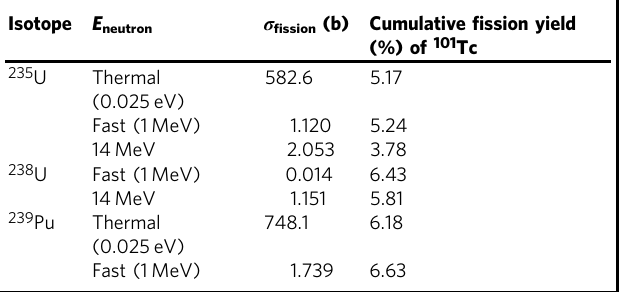
Table 4 Fission yield data for 101 Tc originating from various fi ssion sources via JEFF3.11 79 . Isotope E